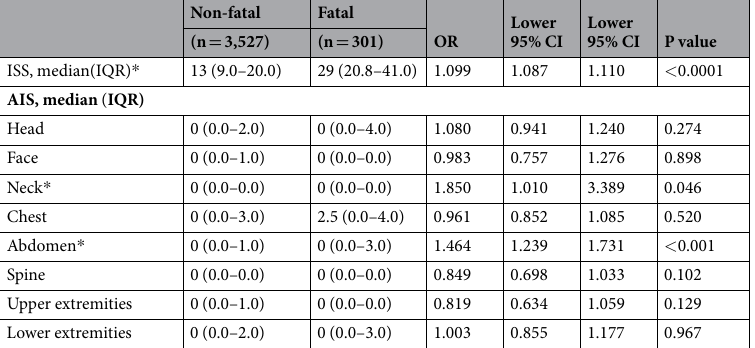
Table 4. Injury Severity Score (ISS) and Abbreviated Injury Scale (AIS) by body region of patients who survived (non-fatal group) versus patients who died (fatal group) during Period A (2004–2008). OR: odds ratio, 95% CI: 95% confidence interval, IQR: interquartile range. * Median values were significantly higher in the fatal group than the non-fatal group.